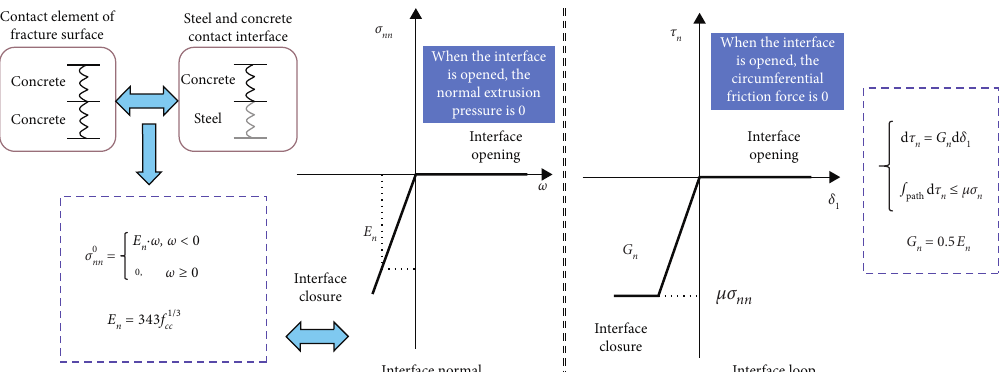
Figure 16: Quantitative expression.